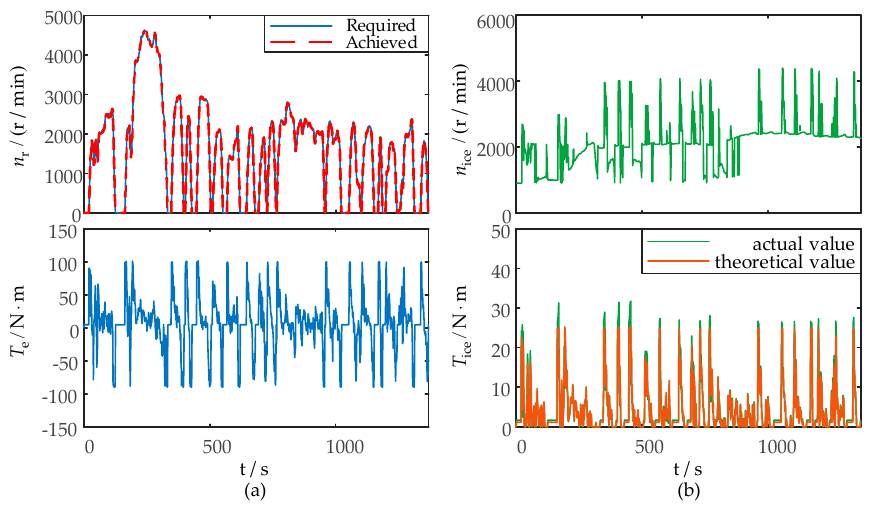
Figure 15. The torque and speed waveforms during the UDDS driving cycle: ( a ) the torque and speed waveforms of CRPM-DFM; ( b ) the torque and speed waveforms of ICE.